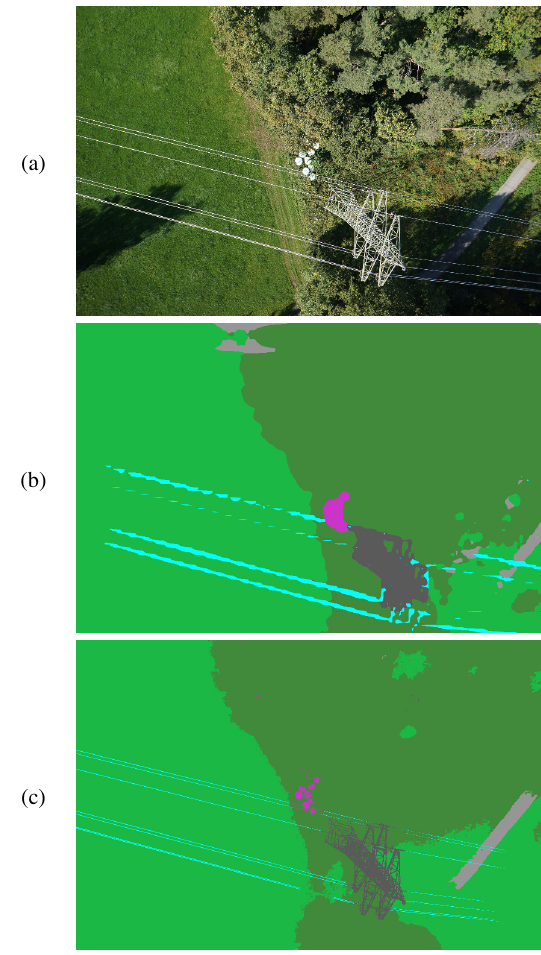
Figure 6. Example semantic segmentation result of a test image of Set1: On the top there is the reference RGB image, in the middle the intermediate result of the FCN and on the last row the final result including the CRFasRNN.